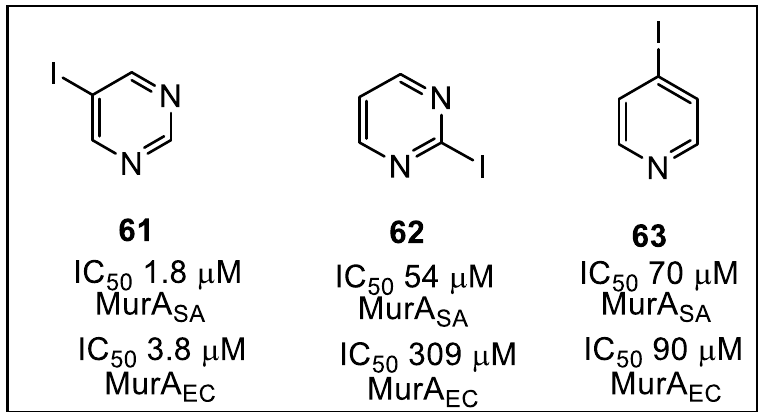
Figure 11. Sulfhydryl active fragments with S N Ar have been identified as inhibitors of the active site cysteine of MurA enzymes from S. aureus (Mur SA ) and E. coli (Mur EC ). The fragments, with fragment 61 being the top hit, have been investigated by glutathione stability HPLC and NMR assays, followed by validated by MurA inhibitory assay.